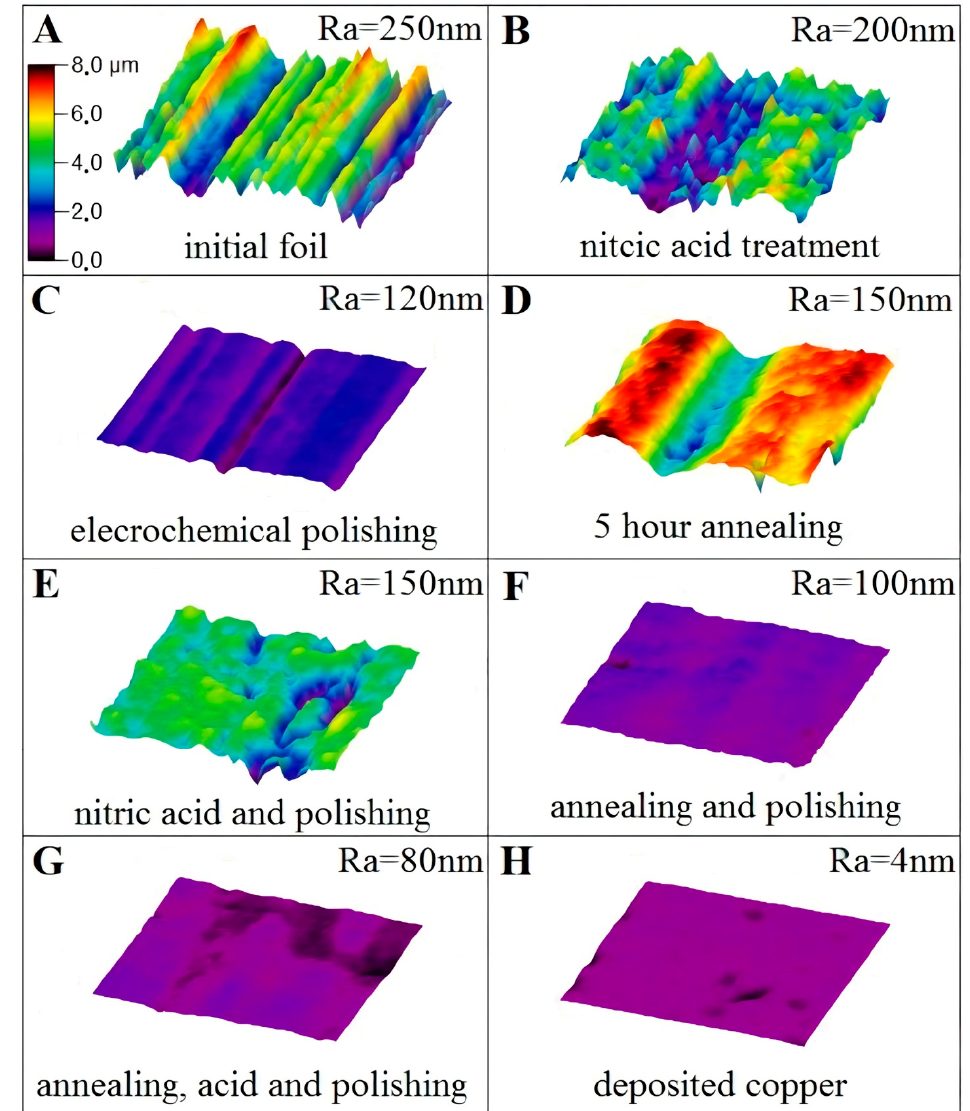
Figure 2. The roughness measurements of copper foil by interference microscope: ( A )—without pre-treatment, ( B )—nitric acid treatment, ( C )—electrochemical polishing, ( D )—hydrogen annealing for 5 h, ( E )—nitric acid treatment and electro- chemical polishing, ( F )—hydrogen annealing and electrochemical polishing, ( G )—hydrogen annealing, nitric acid treatment and electrochemical polishing, ( H )—deposited copper film. All measurements were done froma 50 × 50 micrometers area. All figures have the same scale bar in color grade and it is indicated in Figure